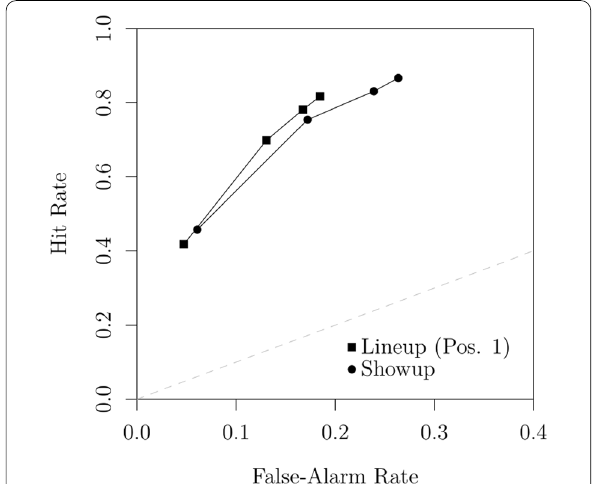
Fig. 12 Confidence rating ROCs (from Wilson et al., 2019) obtained in position 1 of the sequential lineup procedure and the showup